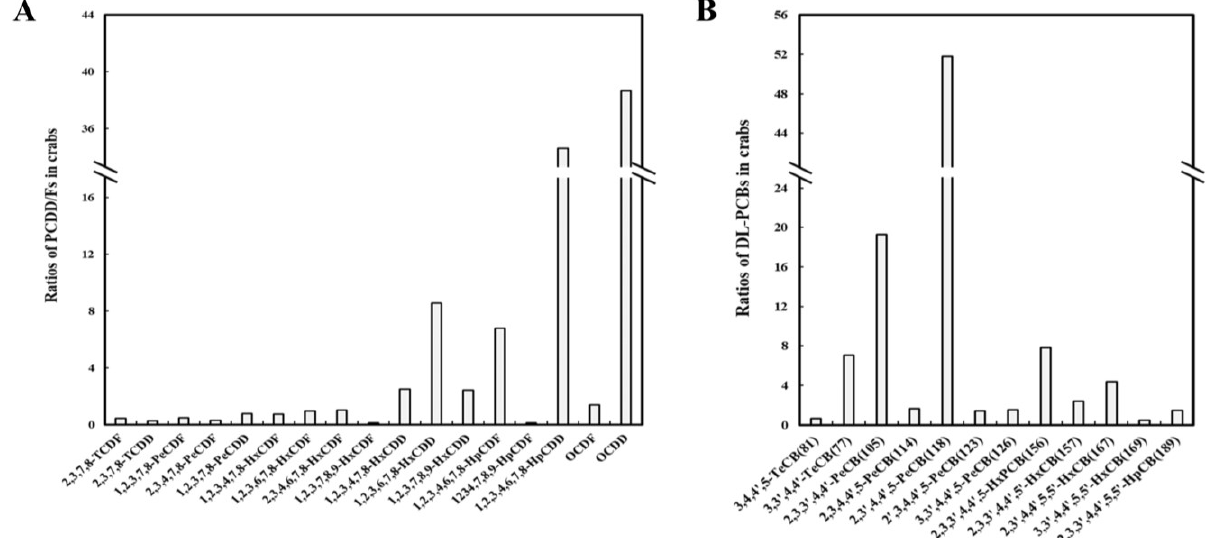
Figure 3. Ratios of PCDD/Fs ( A ) and DL-PCBs ( B ) in farmed Chinese mitten crabs.